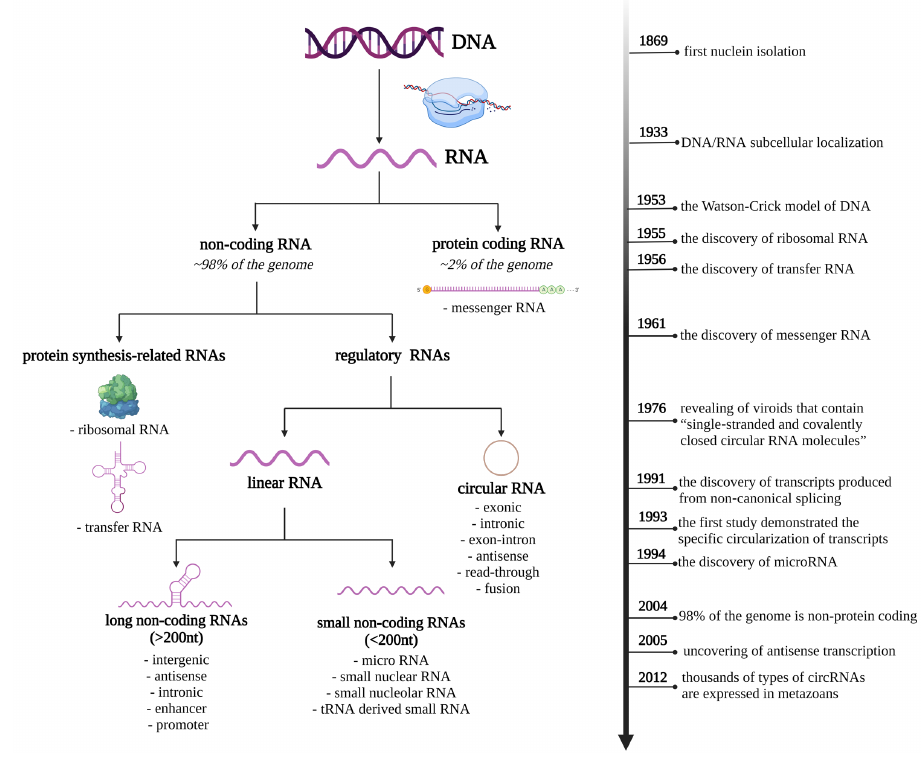
Figure 1. Classification of non-coding RNAs and the timeline of significant events discovering nucleic acids.